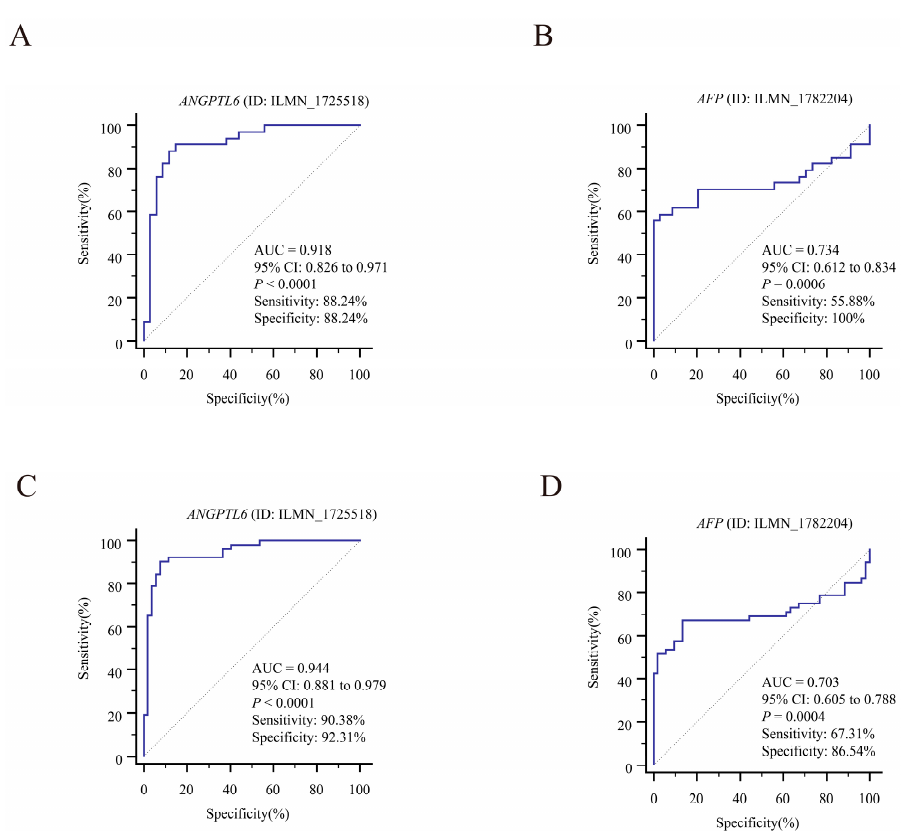
Figure 10. Potential diagnostic values of ANGPTL6 and AFP levels for early-stage and all-stage HCC in the GSE76427 dataset. ( A ) ROC curves for ANGPTL6 to differentiate HCC with early-stage (BCLC 0~A staging) and paired adjacent nontumorous tissues. ( B ) ROC curves for AFP to differentiate early-stage HCC and paired adjacent nontumorous tissues. ( C ) ROC curves for ANGPTL6 to differentiate all-stage HCC and paired adjacent nontumorous tissues. ( D ) ROC curves for AFP to differentiate all-stage HCC and paired adjacent nontumorous tissues.